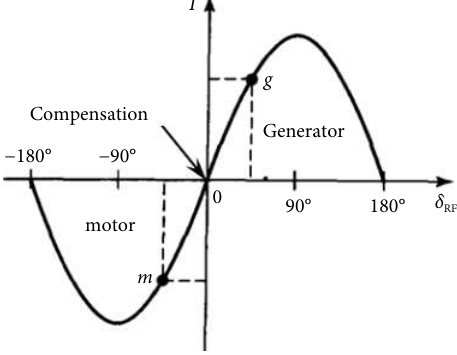
Fig. 10 Torque-angle characteristics of SynM.